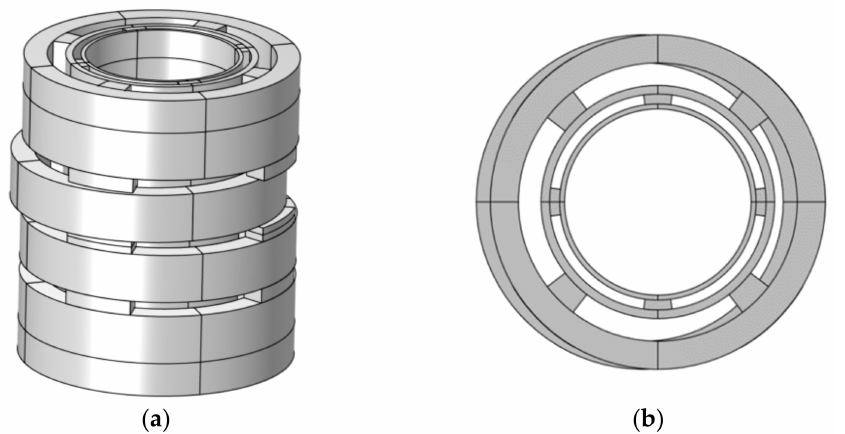
Figure 8. Simulation of the winding eccentricity fault. ( a ) Eccentric 3D model; ( b ) eccentric top